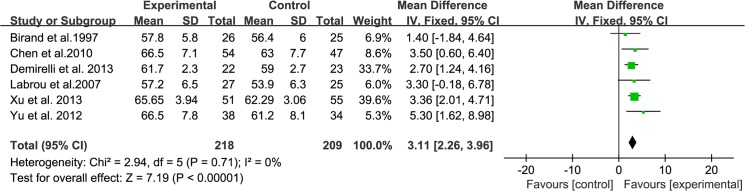
Forest Plots for LVEF.